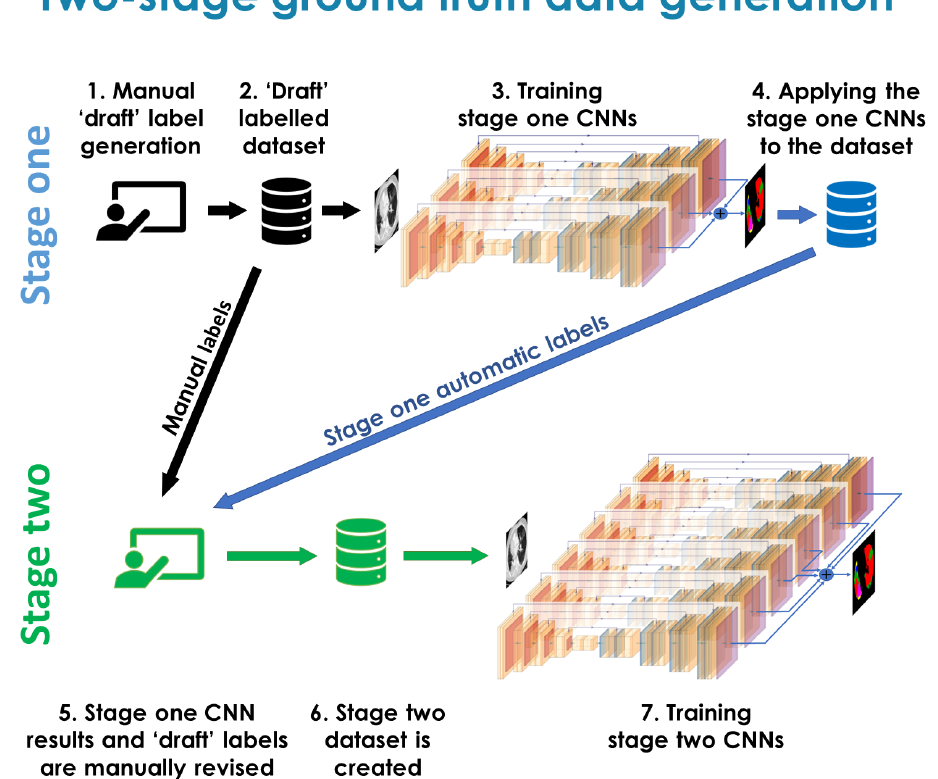
Figure 2. Workflow of the proposed two stage ground truth data generation